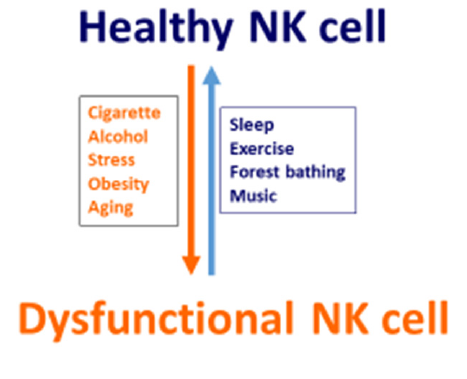
Figure 2. Schematic short list of the impacts of lifestyles and aging on NK cells. Cigarette smoking, alcohol consumption, stress, obesity, and aging suppress NK cell function, leading to a dysfunctional NK cells, whereas sleep, exercise, forest bathing, and listening to music enhance NK cell function with maintained functional healthy NK cells.